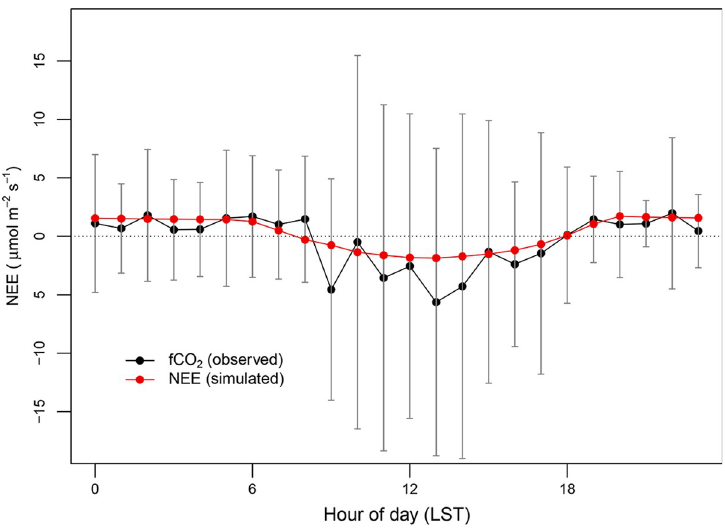
Fig 9. Averaged diurnal variation of simulated NEEs and observed CO 2 fluxes at BO (60 m). Vertical gray lines indicate 1- σ of observations.